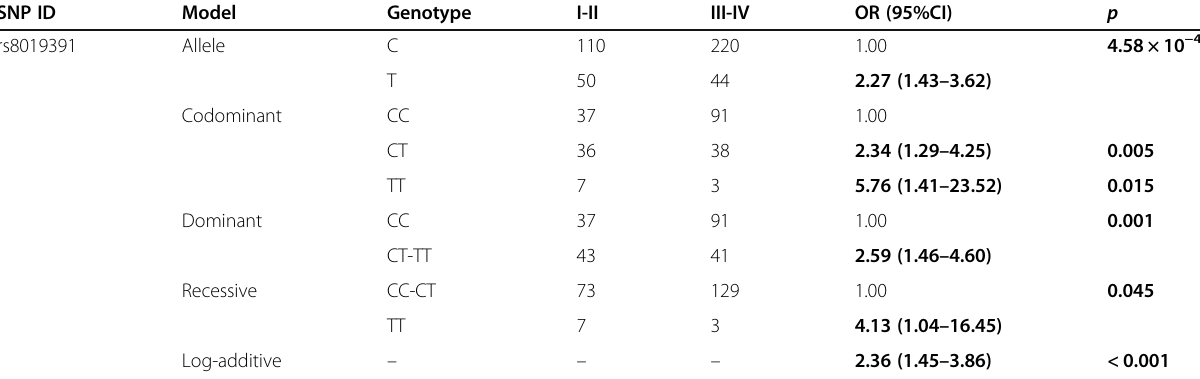
Table 4 Relationship of clinical stage with PGF rs8019391 polymorphism in cervical cancer patients adjusted by age